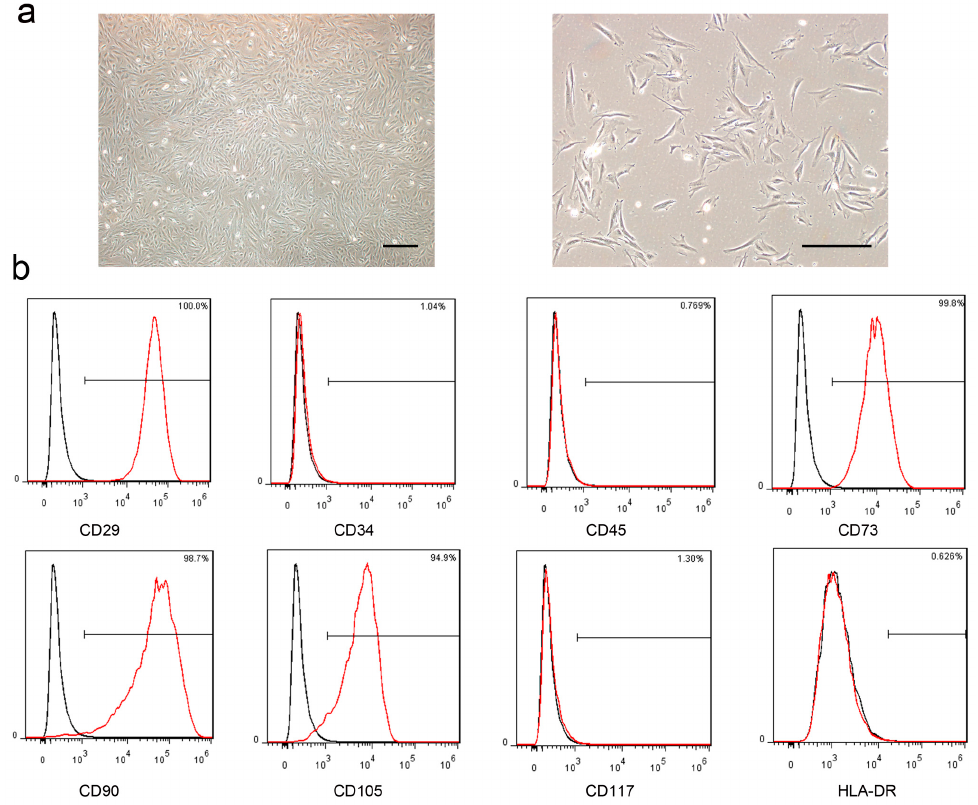
Figure 1. Characterization of MenSCs. ( a ) By microscopy, MenSCs exhibited a spindle-shaped, fibroblast-like morphology (200 × ), Scale bar: 50 µ m; ( b ) Representative surface markers of MenSCs were detected by flow cytometer. The black lines represent the isotype control and the red lines represent the level of the surface markers.